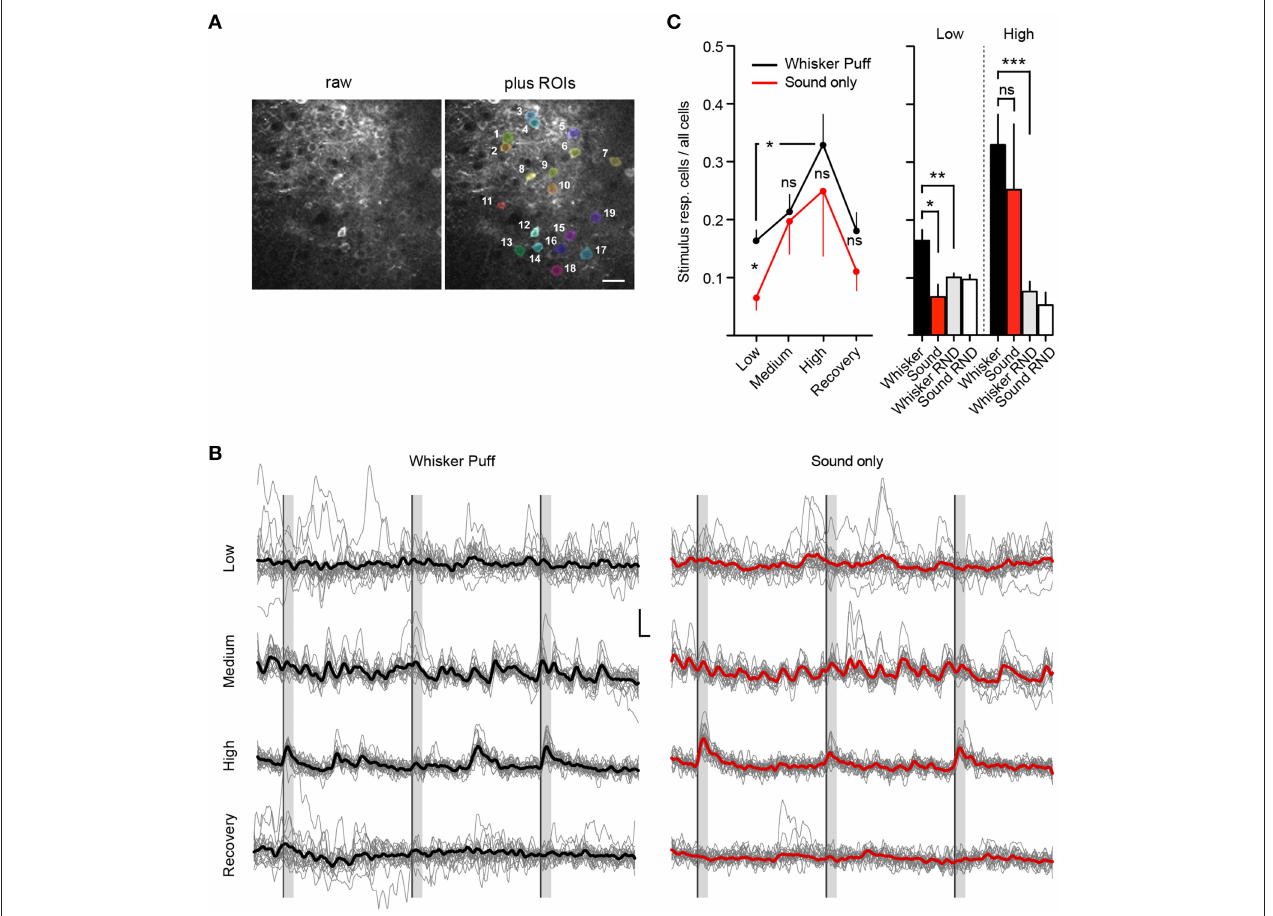
FIGURE 4 | Deep isoflurane anesthesia affects cortical information processing. (A) Example field of view showing the raw image (Left) and an overlay of analyzed ROIs (Right) , scale bar 25 µ m. (B) Example traces of imaged cells shown in (A) for whisker puff and sound only trials for each isoflurane concentration, inset: 10% ∆ R/R (y-axis), 2s (x-axis), thick lines indicate group average. (C) Fraction of neurons responding to whisker stimulation by an air-puff and sound-only stimulation under low (0.5%), medium (1.0%), and high (1.5–2.0%) isoflurane doses, and after recovery (0.5%) (Mean ± SEM, * p < 0.05, only significant differences between stimulation groups and isoflurane treatments are marked in the figure). The differences in sensory responsiveness at low isoflurane vanished when the stimulus detection windows were randomized within datasets (RND) (see Section Materials and Methods) (mean ± SEM, ** p < 0.01, *** p <